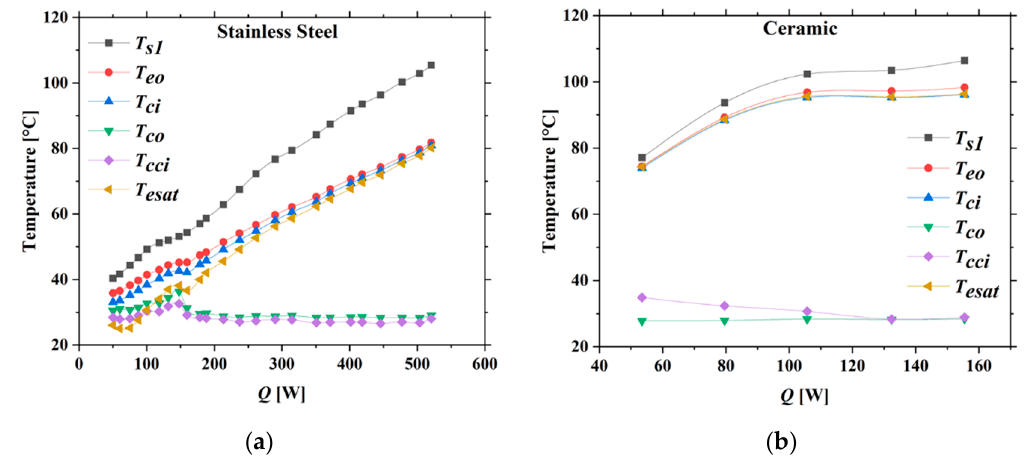
Figure 9. LHP’s temperatures distribution at different heat loads when installed with ( a ) a stainless-steel wick and ( b ) a ceramic wick. Table 7. Test results of pore distribution measurement by the mercury injection method.